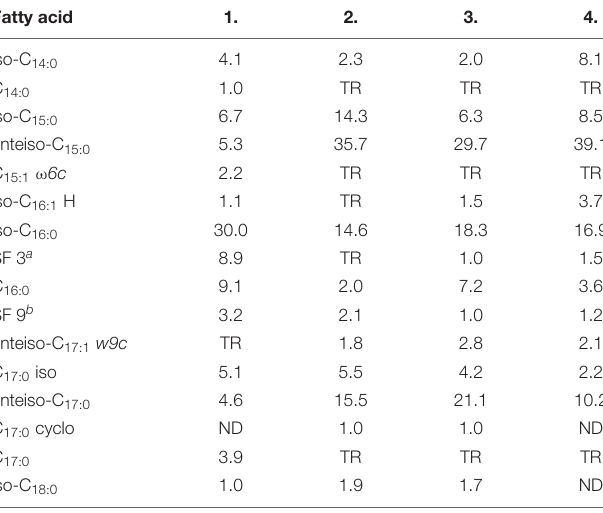
TABLE 1 | Phenotypic characteristics that differentiate Streptomyces tardus sp. nov. from closely related Streptomyces species. Test 1.